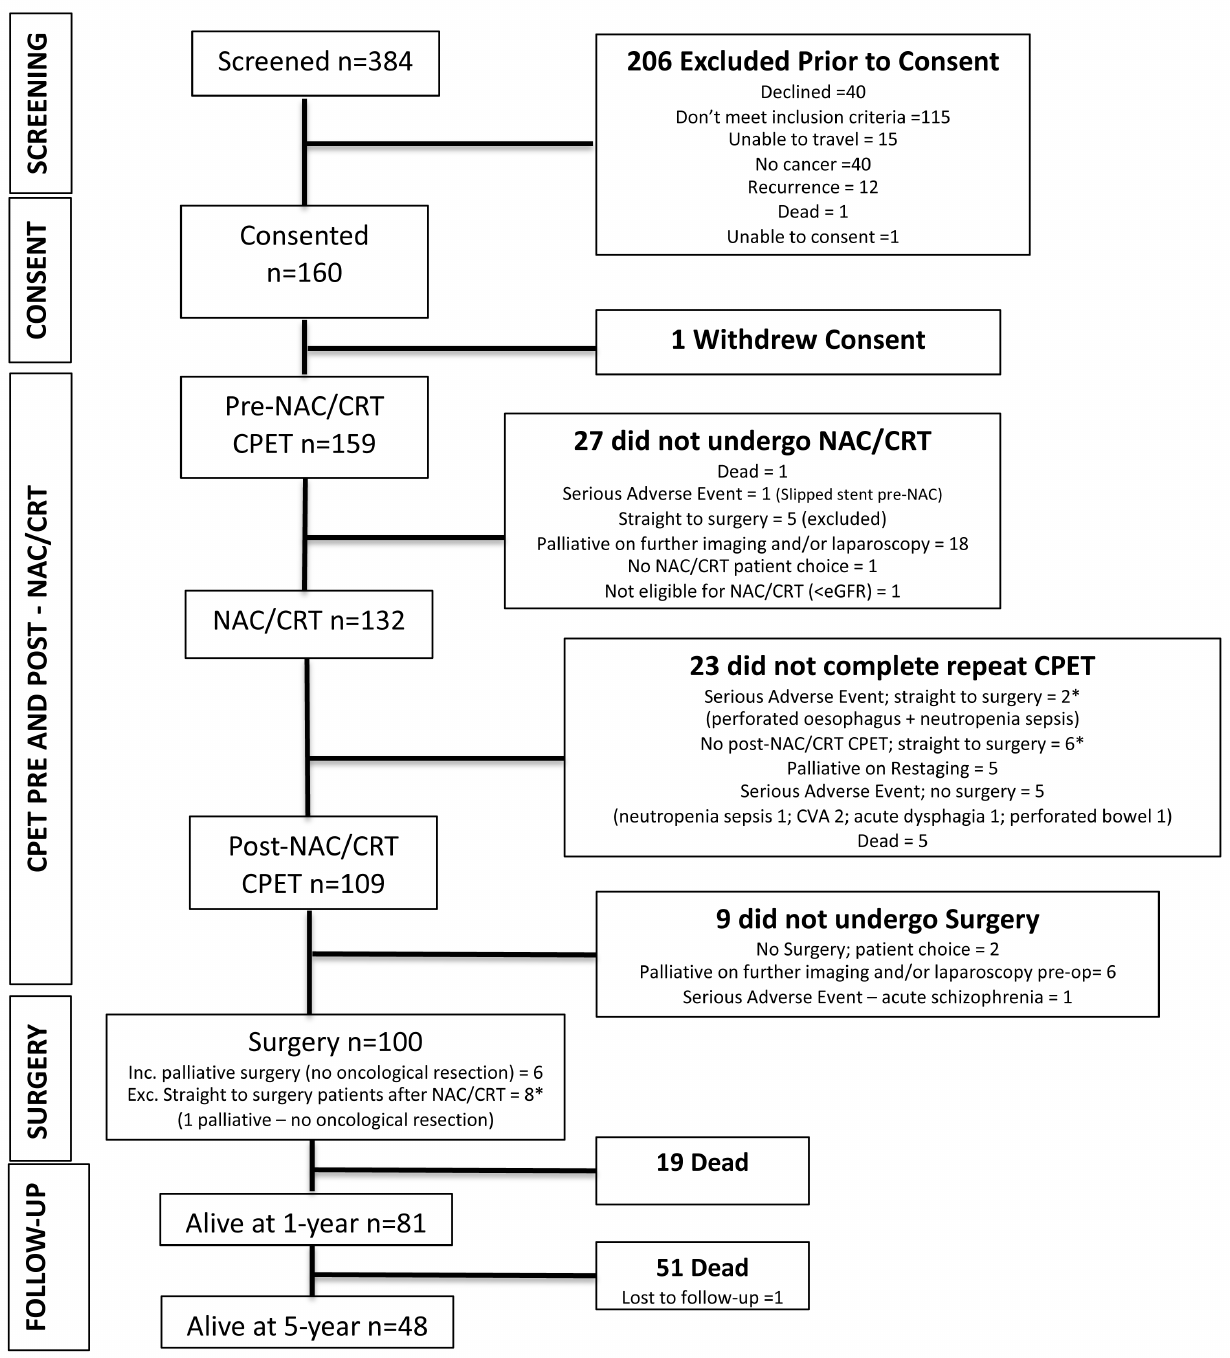
Figure 1. Study enrolment and follow-up. Of the 160 patients who were enrolled, 159 had pre-neoadjuvant chemo/chemoradiotherapy (NAC/CRT) cardiopulmonary exercise testing (CPET), 27 did not undergo NAC/CRT of which 5 went straight to surgery and were excluded. 132 patients underwent NAC/CRT of which 8* went straight to surgery and a further 15 did not complete post-NAC/CRT CPET. 109 patients underwent post-NAC/CRT CPET and 108 underwent surgery. * denotes patients who went straight to surgery after either a serious adverse event during NAC/CRT or patients who did not undergo CPET after NAC/CRT.